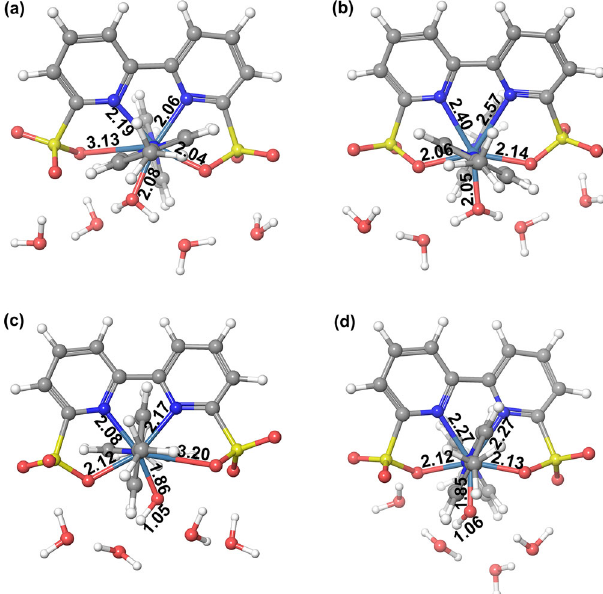
Fig. 5 DFT optimized structures. DFT optimized geometries for the structure conversion of [Ru III − OH 2 ] + between a 6-coordination and b 7-coordination con fi gurations, and [Ru IV − OH] + between c 6-coordination and d 7-coordination con fi gurations. The bond lengths are given in